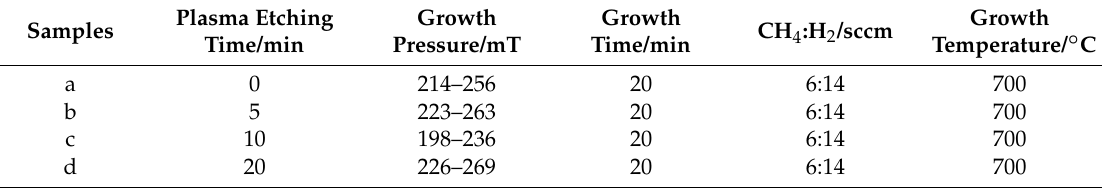
Figure 1. Stainless steel sample with CNTs. Table 1. Growth parameters for the carbon nanotubes (CNTs) on stainless steel